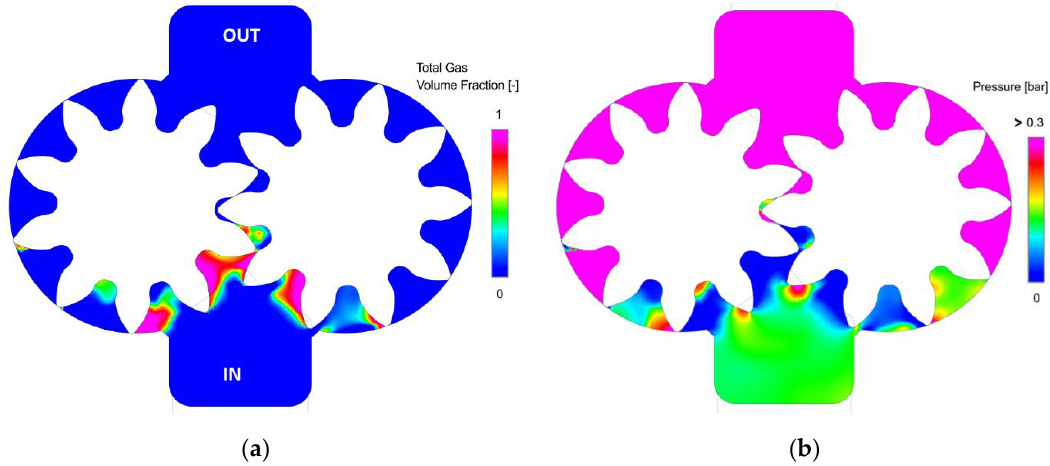
Figure 15. Simulated total gas volume fraction ( a ) and pressure field ( b ) at 2000 rpm with inlet pressure 0.13 absolute bar. Thrust plates type A.